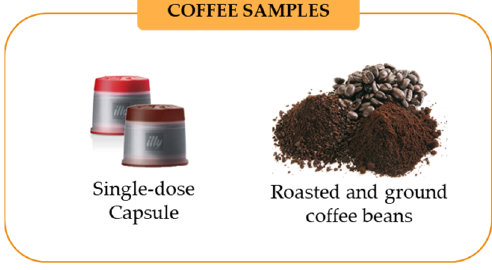
Figure 2. Coffee samples forms for EC preparation. Table 1. Espresso coffee origins and labels. C: capsules; R: roasted coffee beans. Sample N ° .